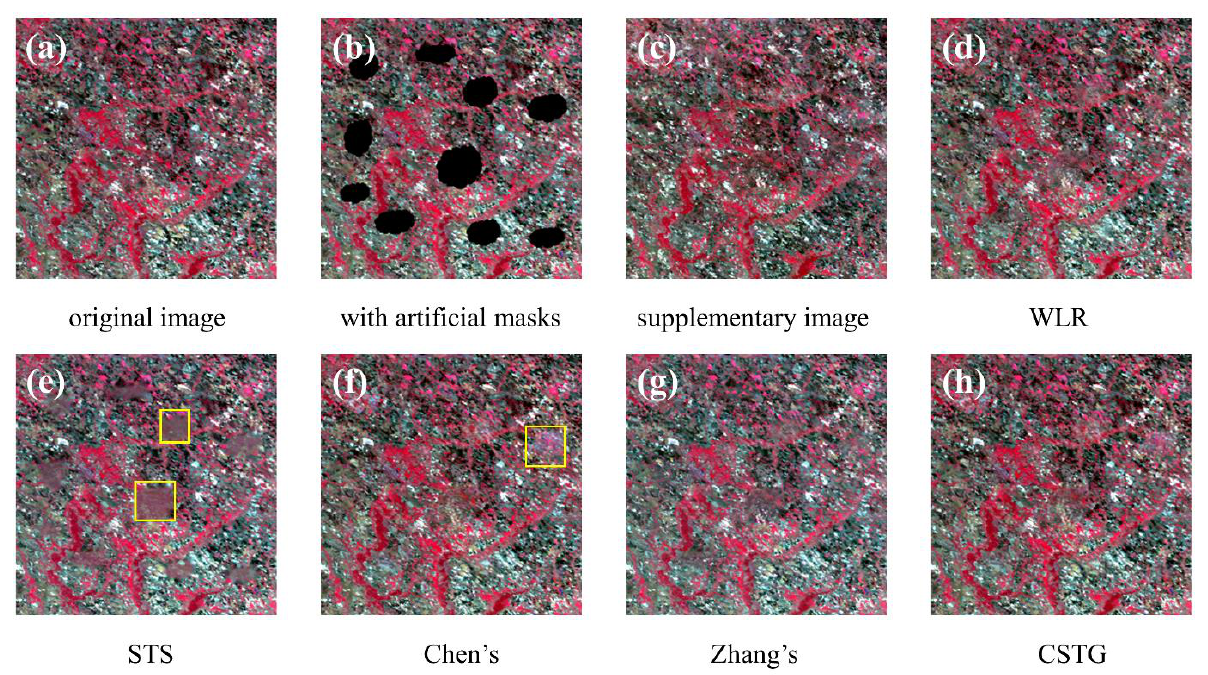
Figure 5. Comparisons of the observed images and the gap-filled images when applying small and dispersive masks are shown for ( a ) the original image acquired on 30 September 2020, ( b ) the image with artificial masks, ( c ) the supplementary image acquired on 8 October 2020, and the images recovered by ( d ) WLR, ( e ) STS, ( f ) Chen’s method, ( g ) Zhang’s method, and ( h ) CSTG.